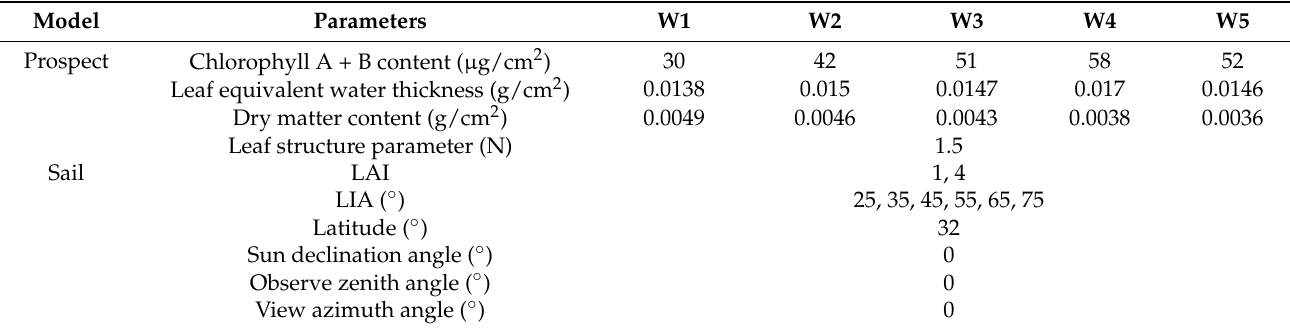
Table 4. The input parameters of Prospect and Sail models when simulating the impact of LIA on the leaf-canopy scale effect.